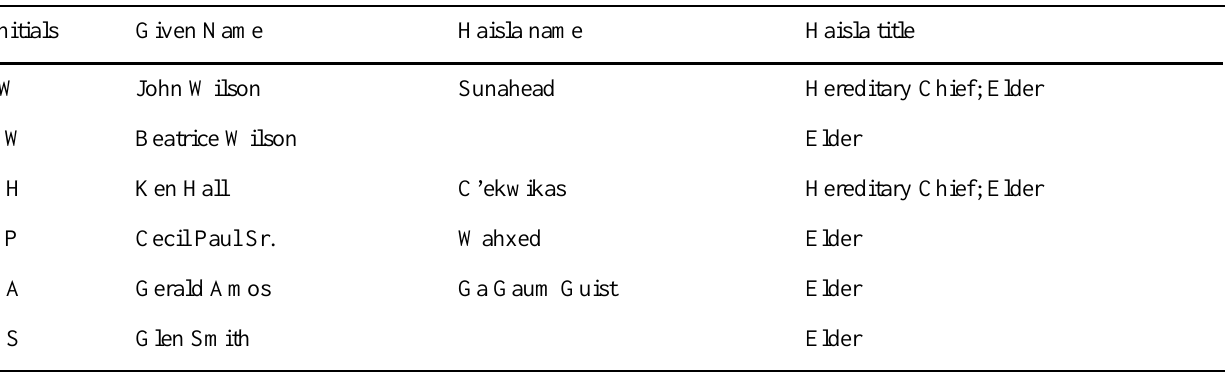
Table 1 . Members of the Haisla First Nation who were interviewed for local and traditional knowledge of Kitlope River salmon, associated fisheries, and local climate